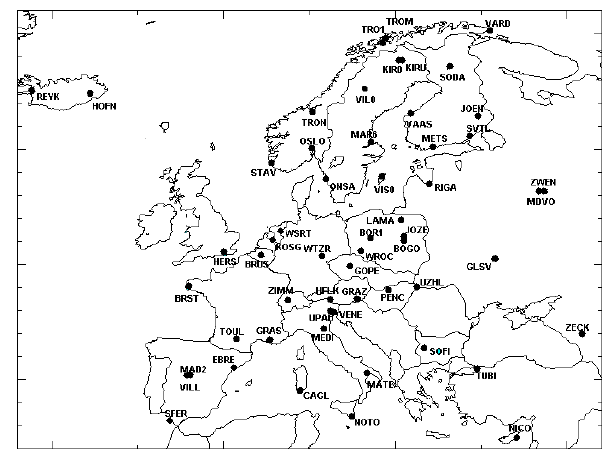
Fig. 2. Map of the EPN stations used in this paper.